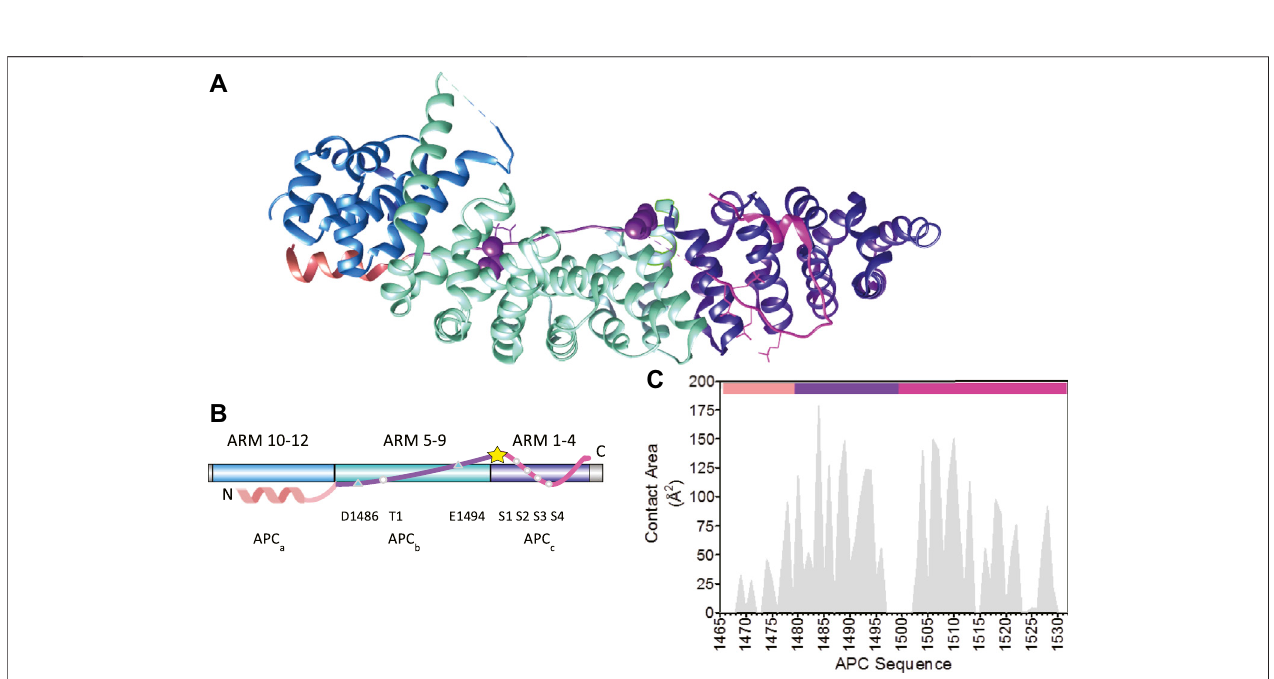
FIGURE 2 | The interaction of the third 20aa repeat (R3) of APC with β -catenin. (A) Schematic representation of the structure of the armadillo repeat domain of β - catenin in complex with the phosphorylated third 20aa repeat of APC(R3) (PDB 1TH1) (Xing et al., 2004). The three subdomains of APC R3 are coloured: the N-terminal α -helical domain in peach (APC a ), the lysine binding domain in purple (APC b ), and the phosphorylation domain in pink (APC c ). The amino acids that are phosphorylated are represented as sticks and the two lysine-interacting amino acids as spheres. The β -catenin ARM repeats that bind to the three APC subdomains are coloured: ARM 10 – 12 in blue, ARM 5 – 9 in turquoise, and ARM 1 – 4 in dark blue. (B) Schematic showing the location ofthe key β -catenin-binding residuesin APC R3. APC and β - catenin are coloured as in (A) . The fi ve phosphorylated residues, S1 – S4 and T1, are represented by circles. The lysine-binding residues D1486 and E1494 are represented by triangles. The site of the single cysteine residue (C1501) is represented by a yellow star. (C) Buried surface area by residue of pAPC R3 in the complex with β -catenin derived from PDB 1TH1 calculated using Cocomaps (http://www.molnac.unisa.it/BioTools/cocomaps, Vangone et al., 2011). The bars at the top of the graph indicate the three subdomains of APC R3 coloured as in (A)